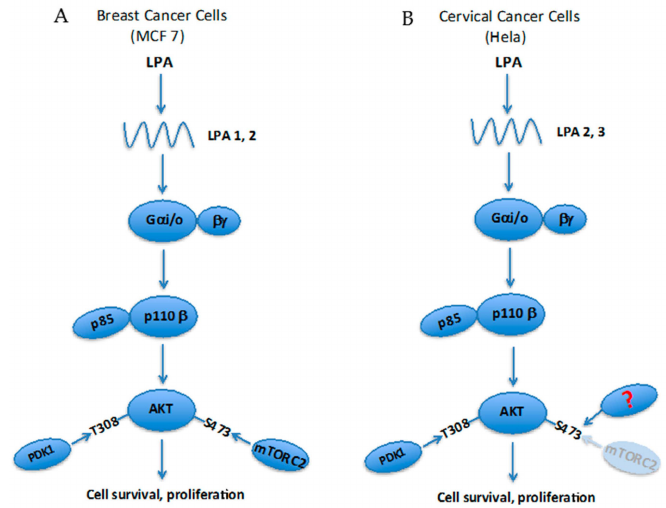
Figure 3. Cell-type dependent regulation of AKT S473 phosphorylation by LPA: ( A ) Knockdown of RICTOR using a specific siRNA disrupts kinase activity of mTORC2. In MCF7 cells (breast cancer cells) this abrogates phosphorylation on Ser473 located in the AKT hydrophobic motif; ( B ) The same approach has no affect on AKT Ser473 phosphorylation in Hela cells (cervical cancer cells). This indicates the presence of an alternate pathway(s) and reflects different LPA receptor expression pattern in these cells; This pathway utilizes another, yet unidentified, kinase (marked with ?) for the Ser473 phosphorylation than